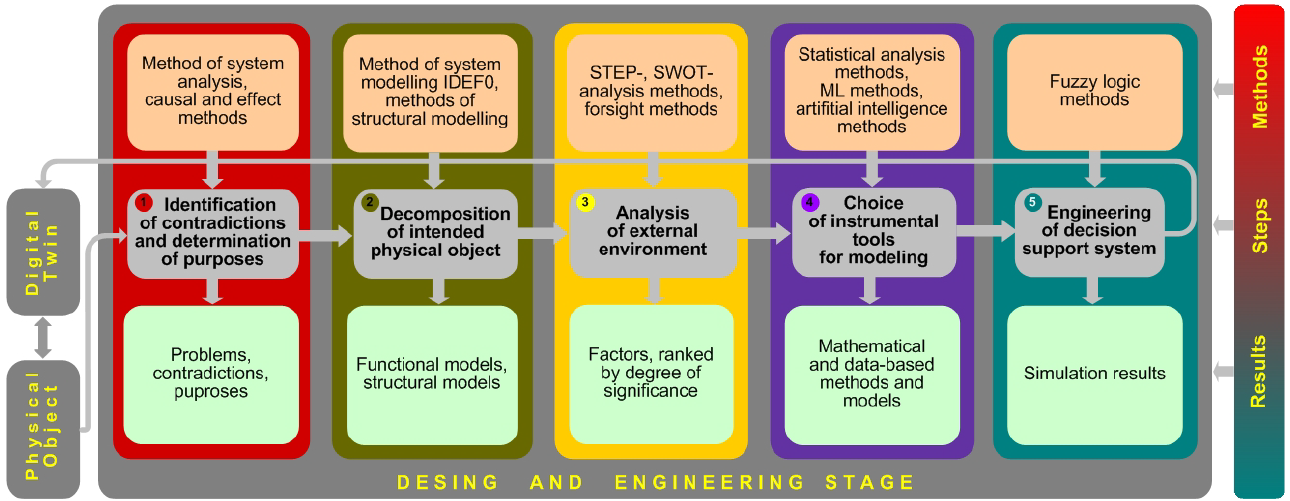
Figure 2. Technology for digital twin development (stage “Design and Engineering”).